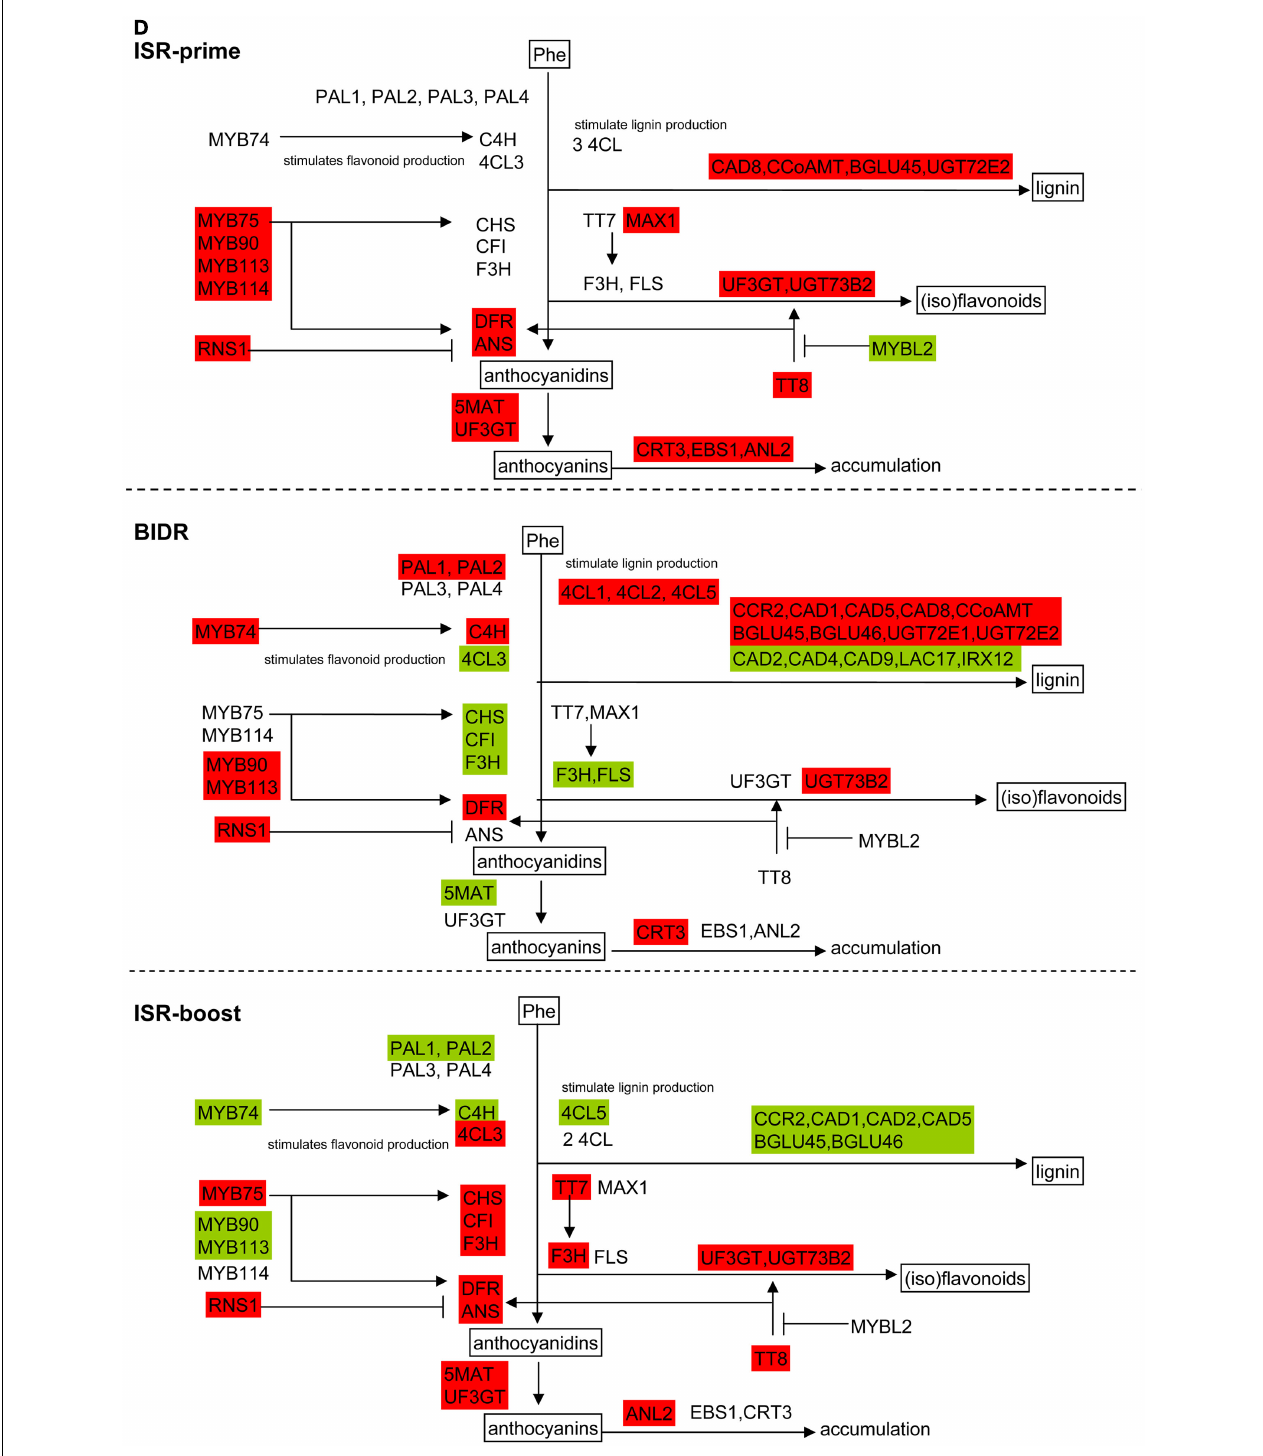
Mittler et al., 2004;Wan et al., 2004; Kotchoni and Gachomo, 2006; Pitzschke et al., 2006;Tsuda et al., 2008;Van Breusegem et al., 2008; Li et al., 2009; Christensen et al., 2010; Foyer and Noctor, 2011; Ranf et al., 2011), those